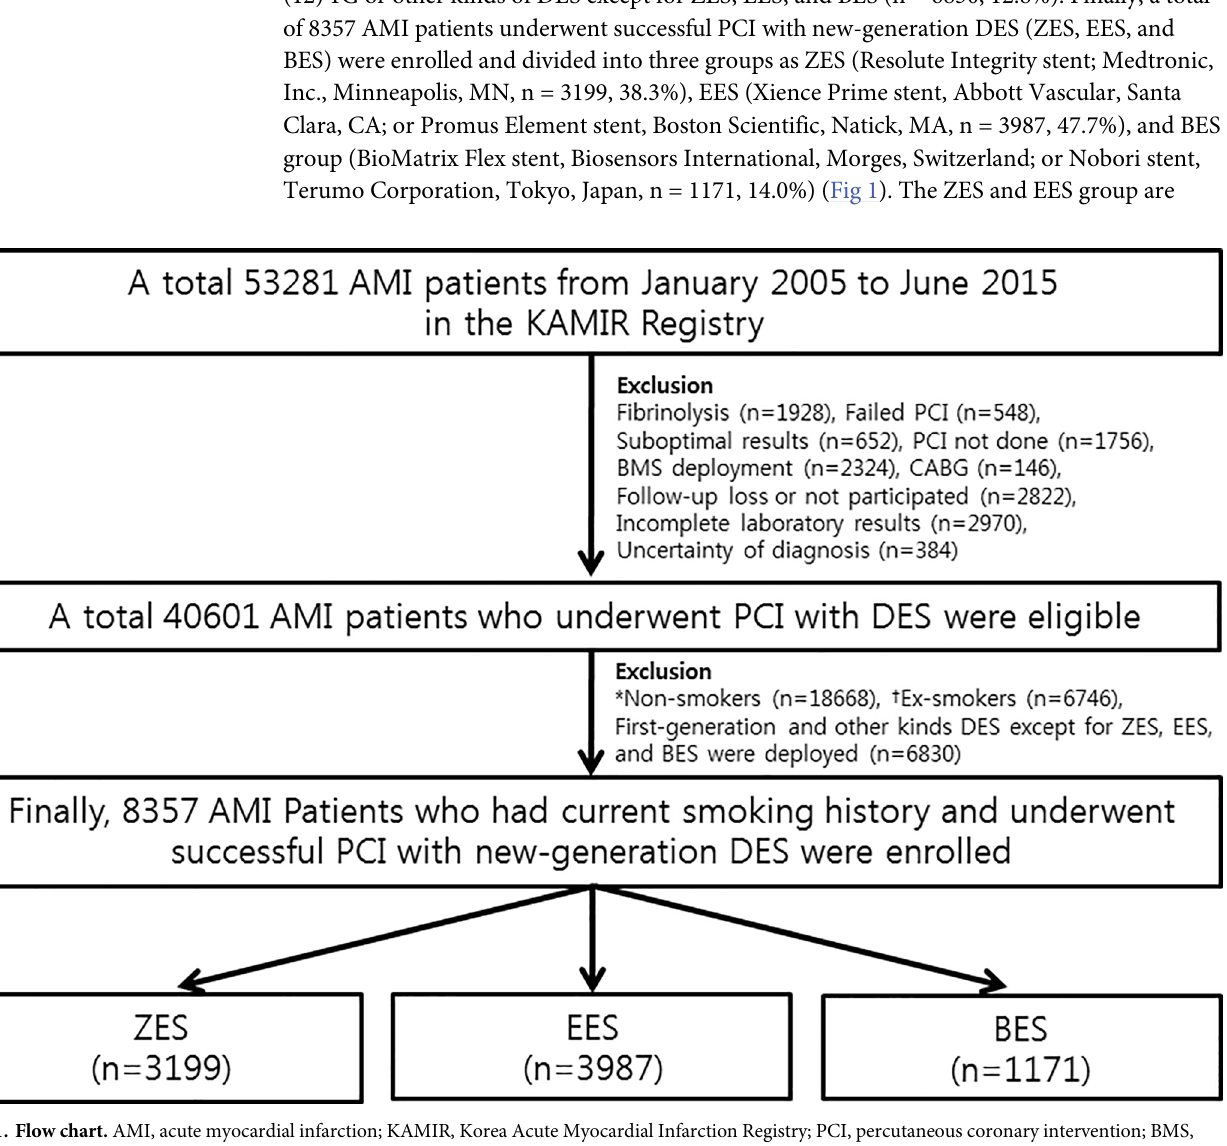
PLOS ONE | https://doi.org/10.1371/journal.pone.0205046 October 5,